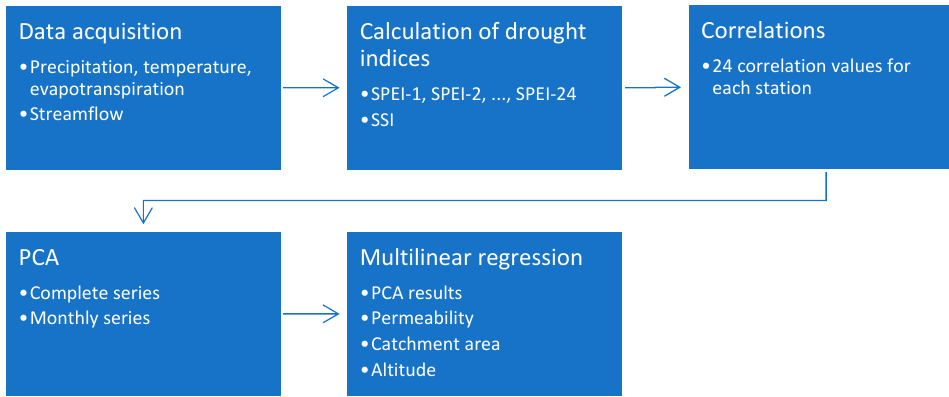
Figure 3. Flowchart of the proposed methodology.